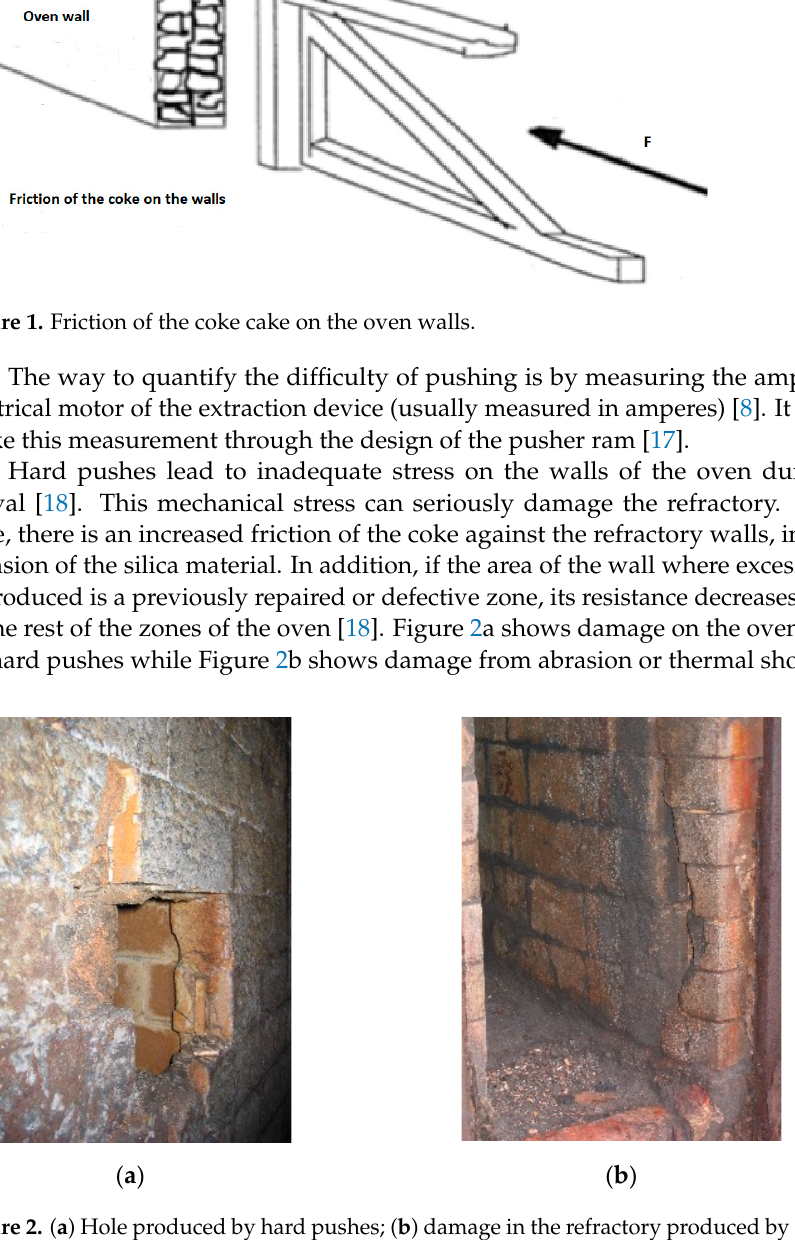
( b ) Figure 3. ( a ) Load exerted by the coke cake; ( b ) breakage of the oven wall. These are the most common causes of coke extraction difficulty: •